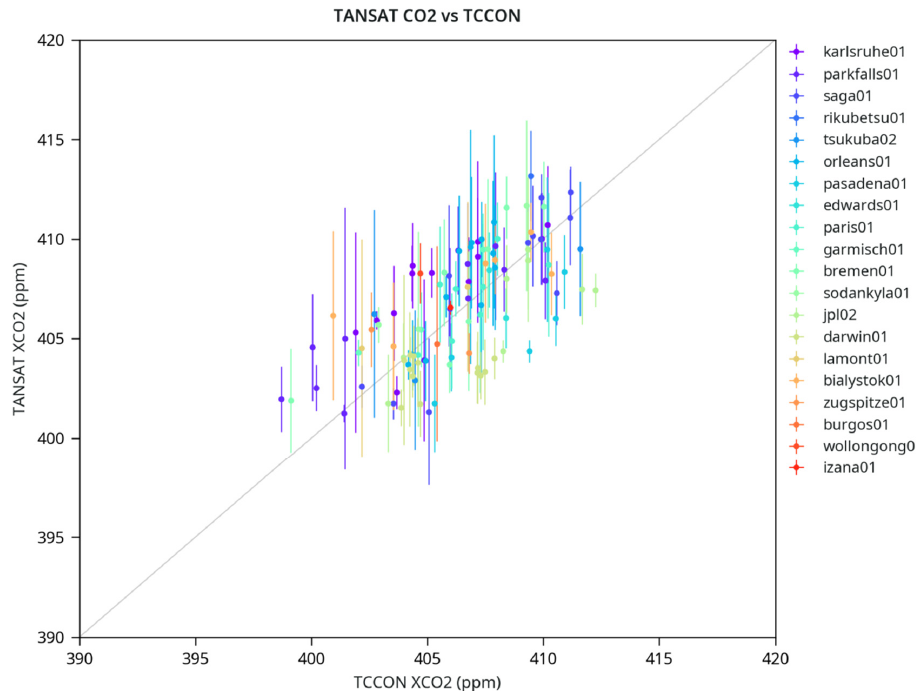
Figure 3. Validation of the averaged XCO 2 retrieved from TanSat nadir measurements with collocated TCCON data. The SD of the XCO 2 retrievals corresponding to each TCCON measurement scene is presented with the length of bar.